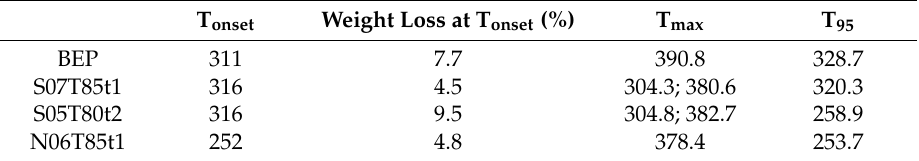
Table 5. Comparisons of T onset , T max , and T 95 of BEP with PeM-CNP samples. T onset